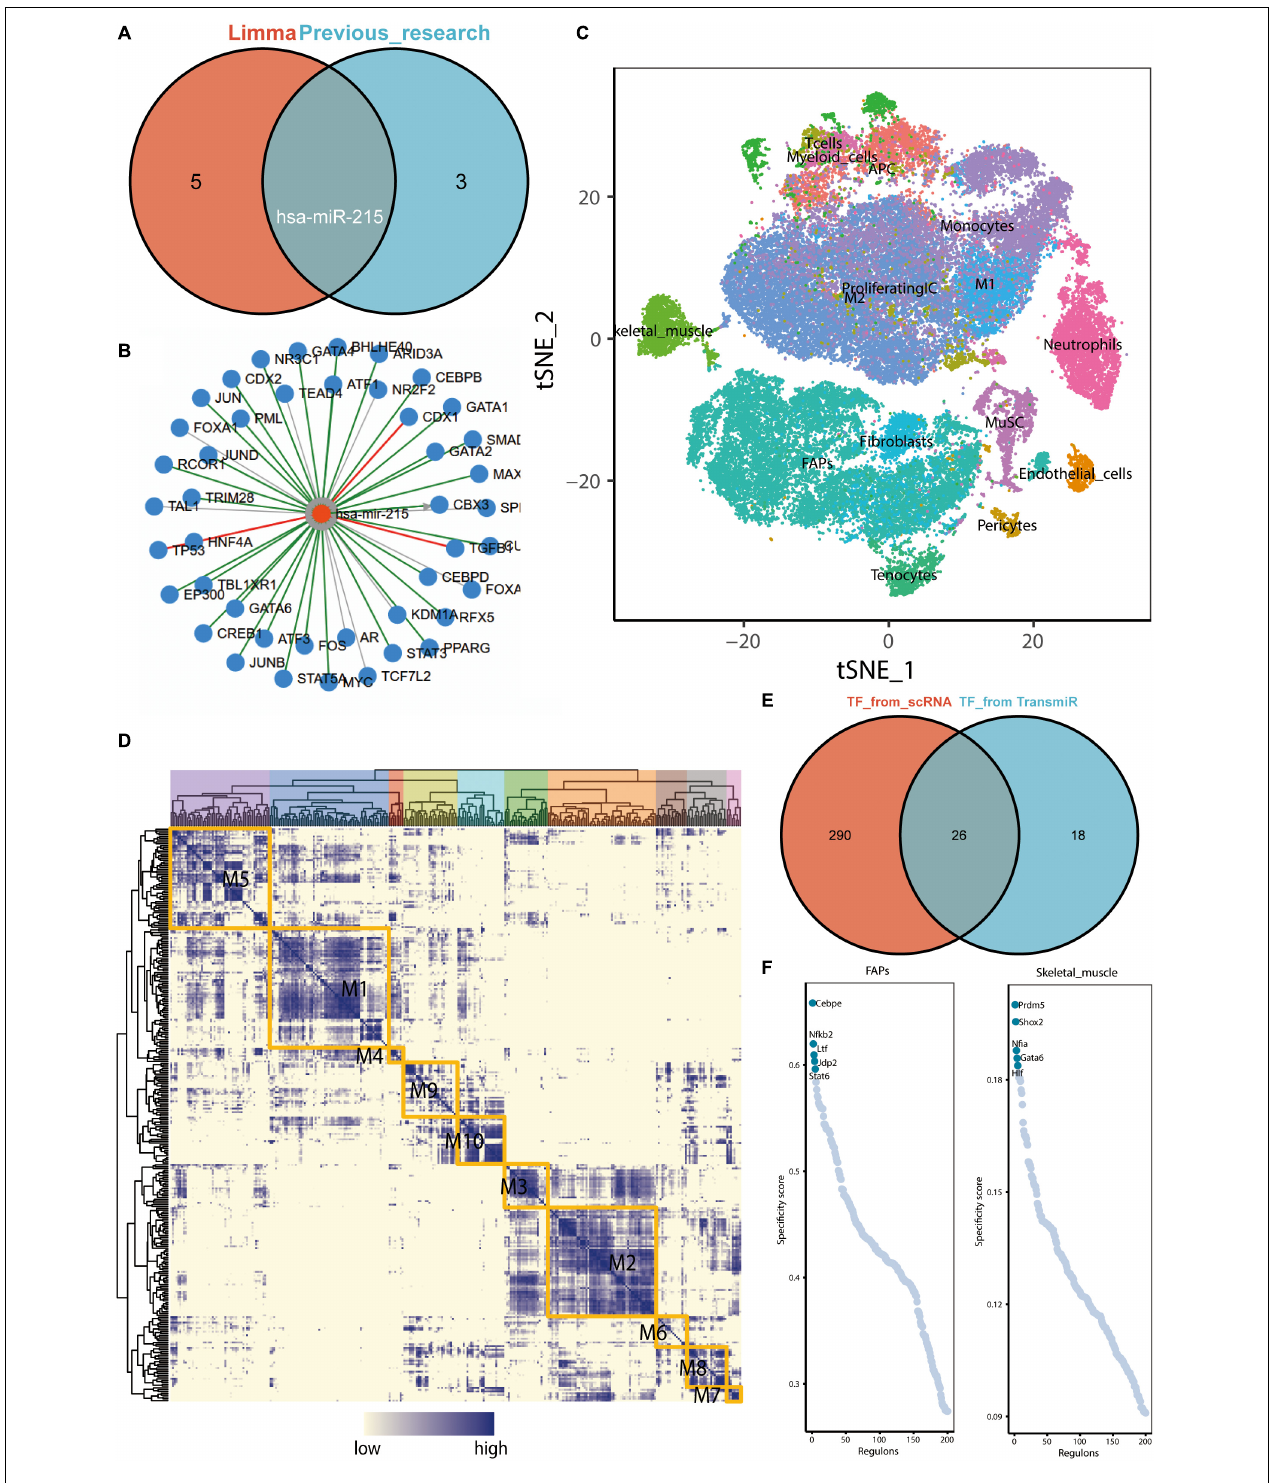
FIGURE 5 | Upregulation of exosome hsa-miR-215 expression in circulating blood after exercise and analysis of key transcription factors in skeletal muscle. (A) Venn diagram demonstrating that miR-215 is the microRNA found to be co-differentially expressed in previous studies and in the GSE144627 dataset. The “limma” here refers to the difference analysis for the GSE144627 dataset. (B) Prediction of upstream transcription factors that may regulate hsa-miR-215 transcription based on TransmiR v2.0. (C) tSNE distribution map of GSE138826 single cell dataset. (D) Regulatory modules identified based on the connection specificity index (CSl) matrix. (E) Venn diagram showing key transcription factors from skeletal muscle single cells ( n = 316) with possible common transcription factors predicted to regulate miR-215 based on the TransmiR database ( n = 44). (F) Ranking of regulators of FAPs and skeletal muscle based on regulatory specificity score (RSS).